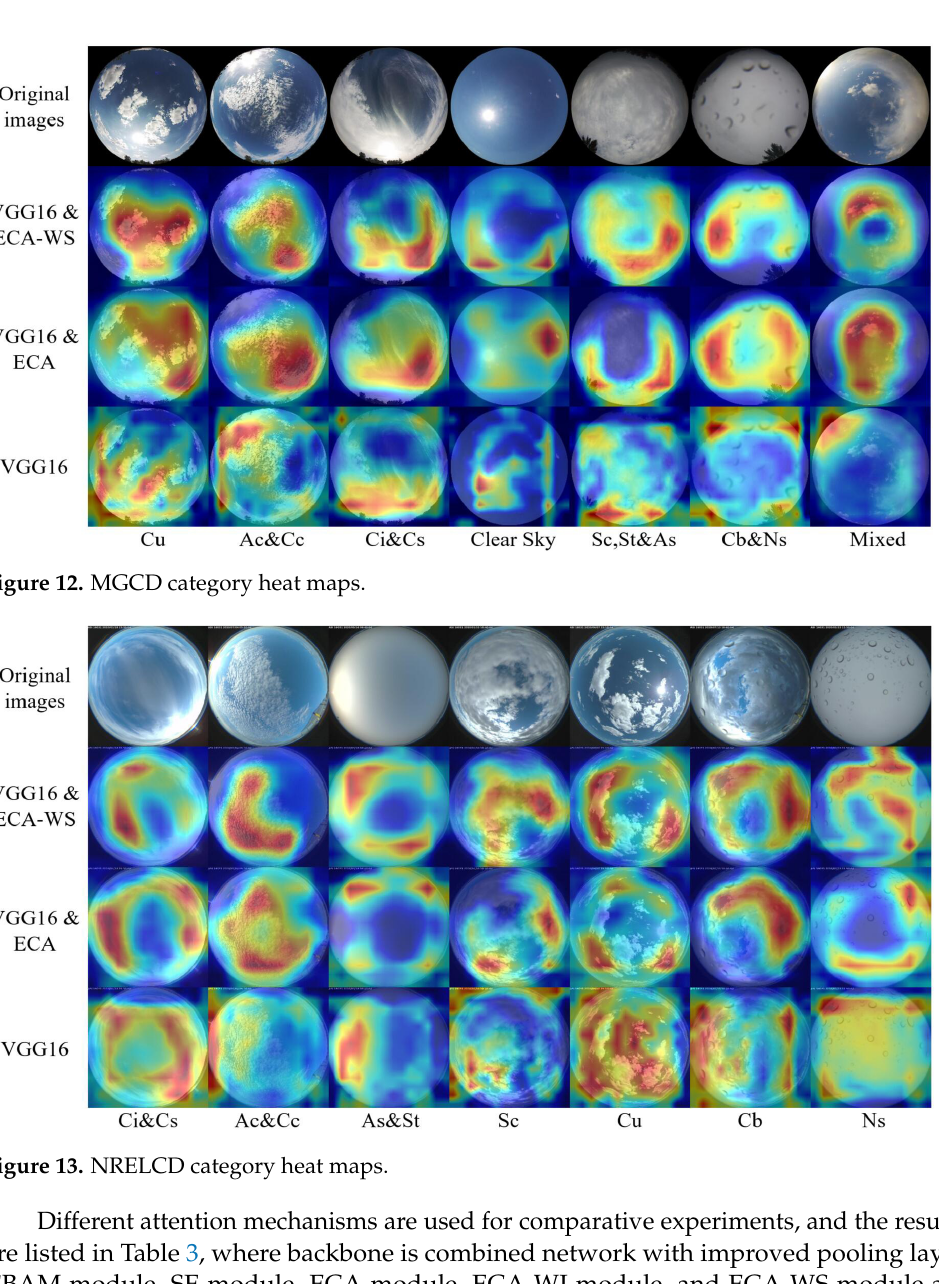
Figure 13. NRELCD category heat maps.